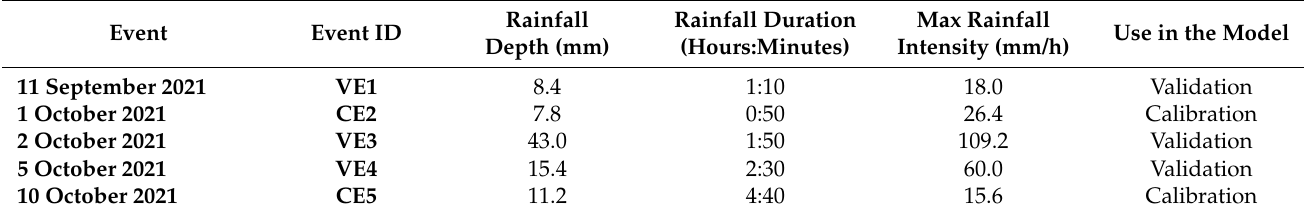
Table 1. Characteristics of rainfall events.